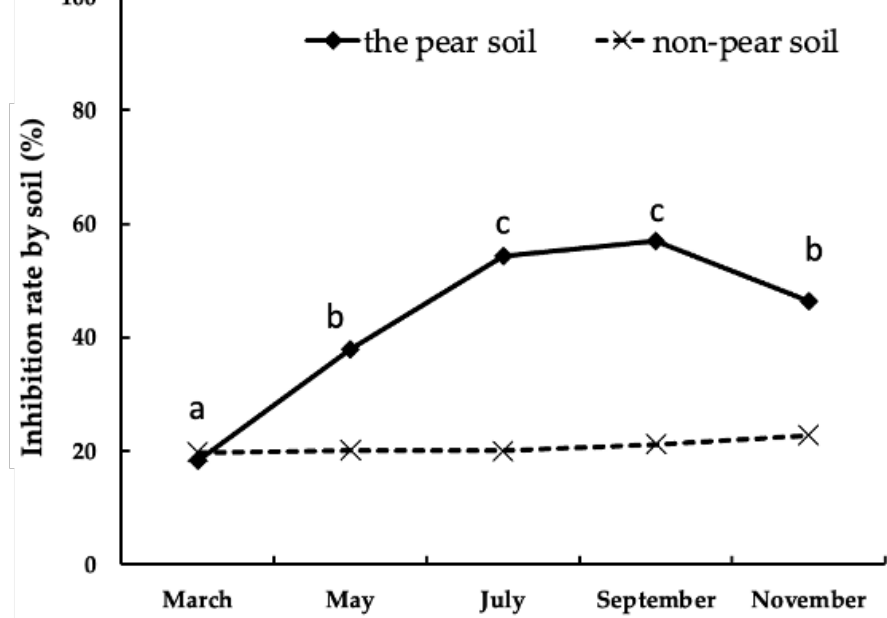
The inhibition rate of soil in which pear trees were cultivated (pear soil) was 18.3% in March before planting, which was the same as in the non-pear soil (Figure 1). It increased to 37.9% in May and 54.3% in July as the tree grew. The highest inhibitory effect was observed in September (57.0%), followed by a decline in November (46.3%). The inhibition rates of the soil in plots without pear trees were 19.7 to 22.7%, and there was no change over time.